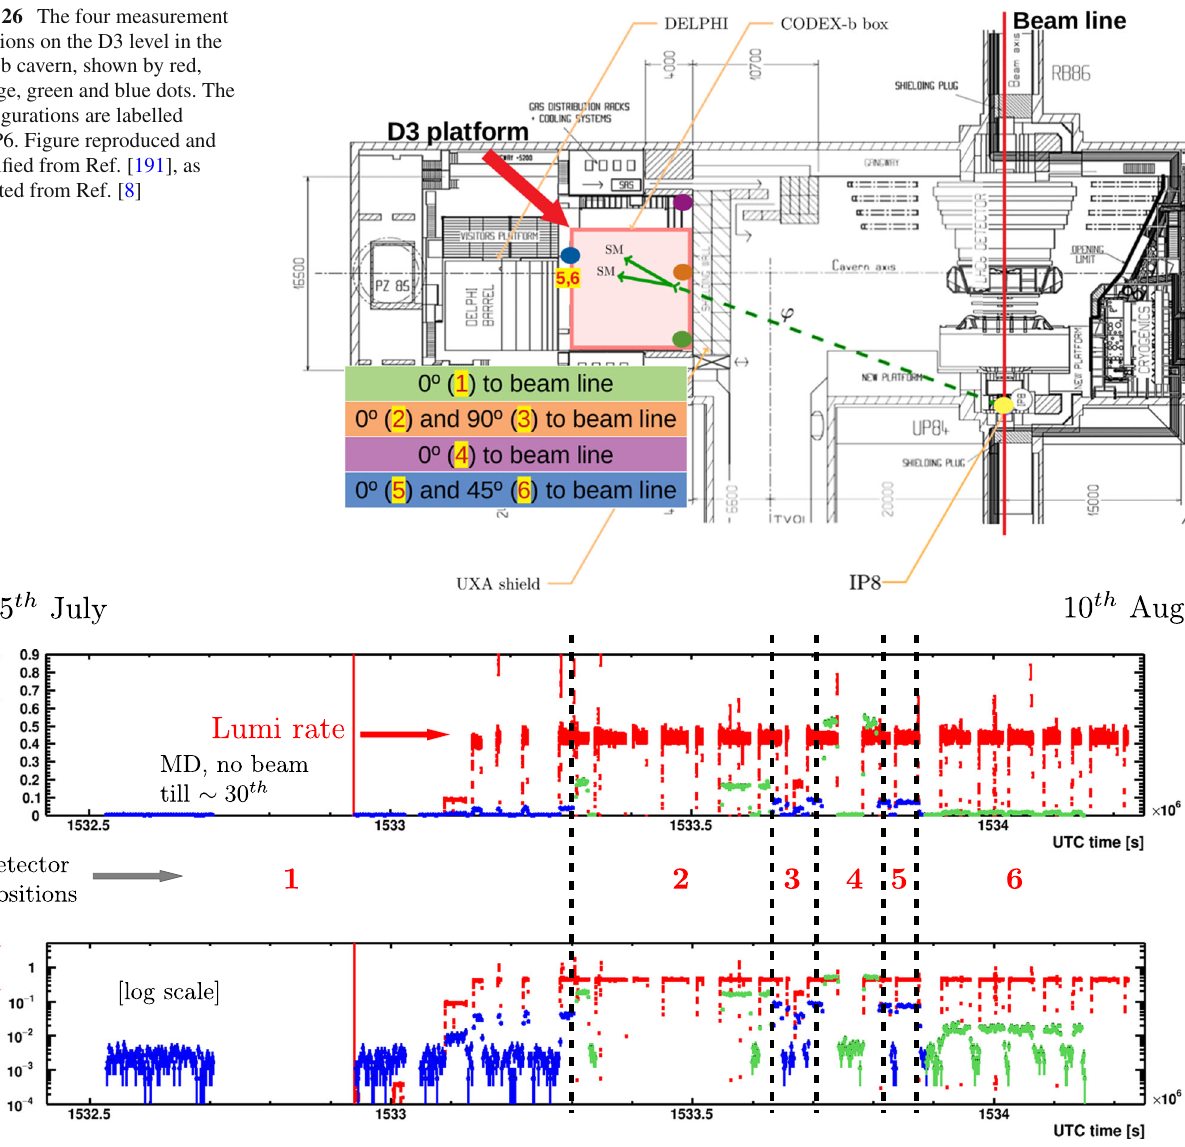
Fig. 26 The four measurement locations on the D3 level in the LHCb cavern, shown by red, orange, green and blue dots. The configurations are labelled P1–P6. Figure reproduced and modified from Ref. [191], as adapted from Ref. [8]